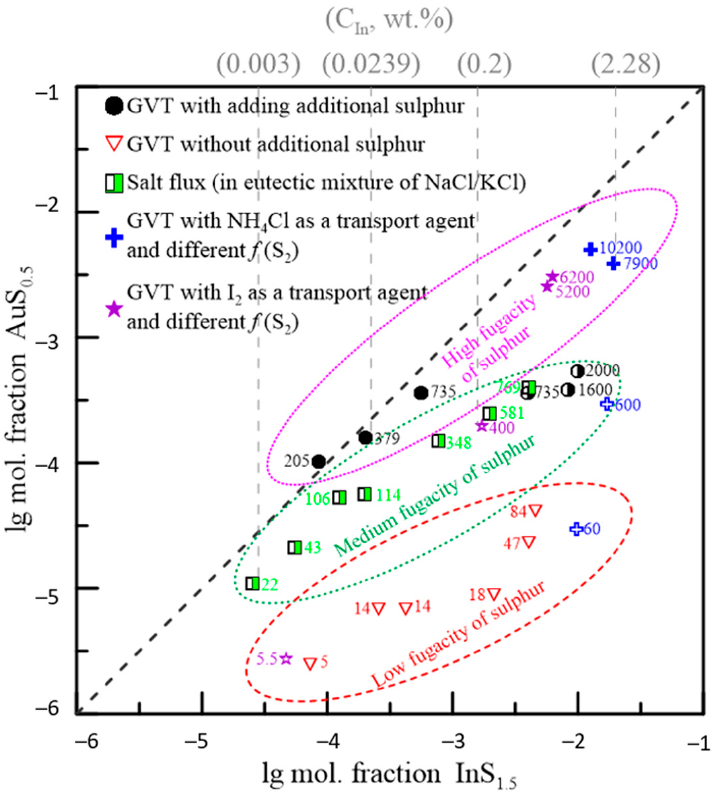
synthetic crystals of greenockite (Table 28; Figure 41 [111]). The concentration of Au in In-